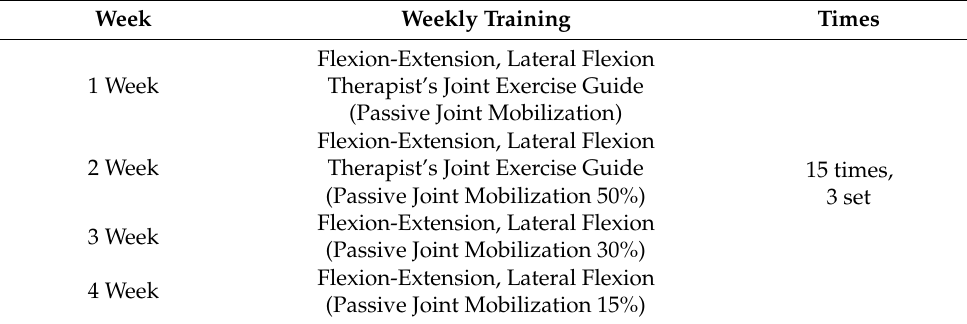
Table 1. Thoracic active exercise with